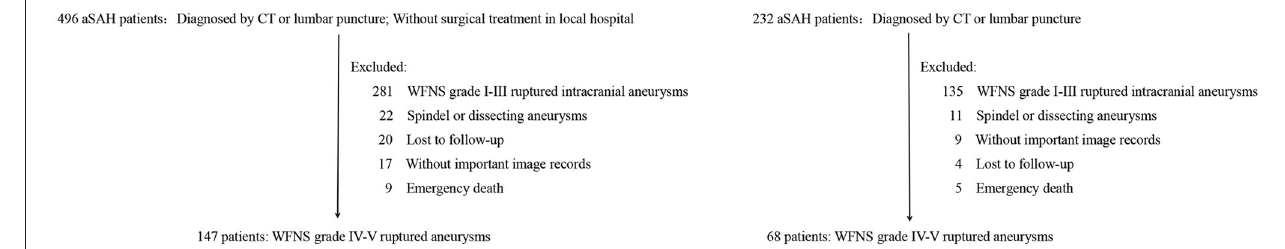
FIGURE 1 | Study flow diagram.